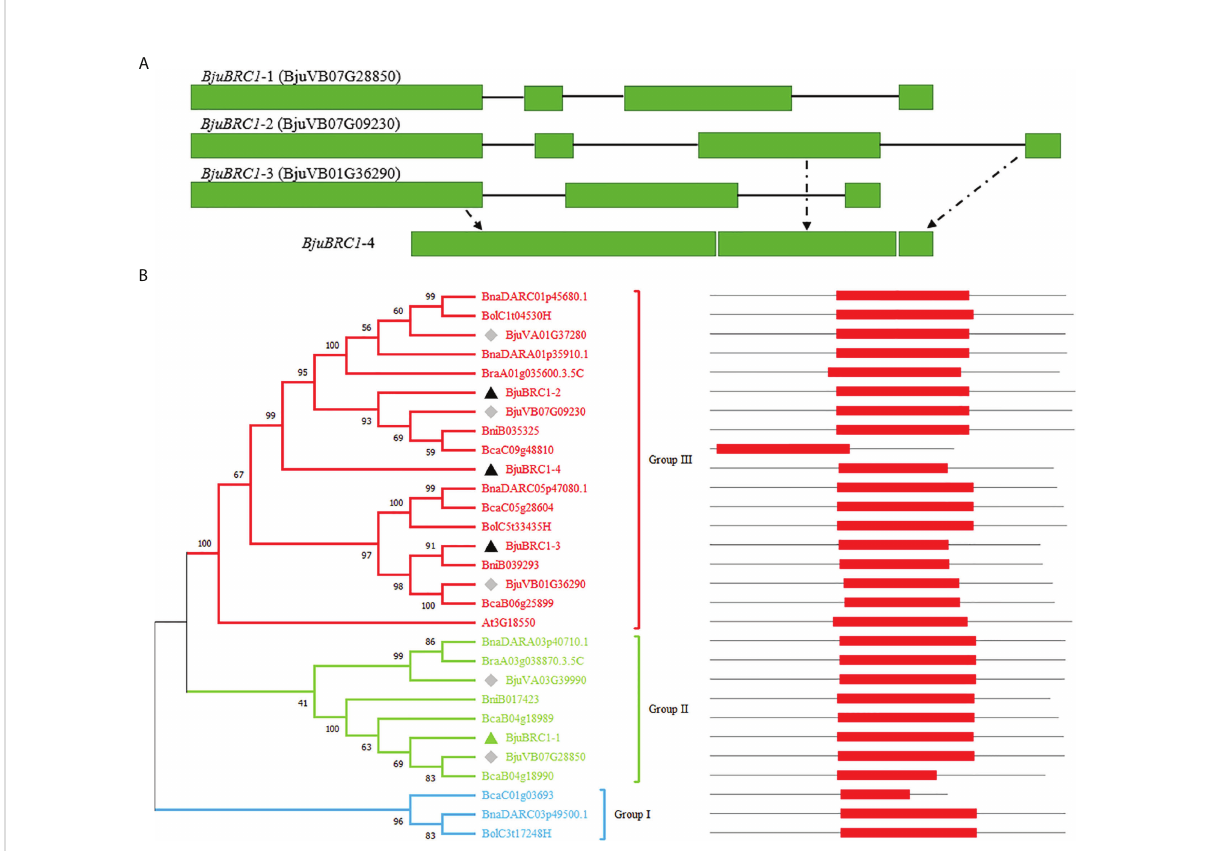
FIGURE 1 BjuBRC1 gene structure and phylogenetic tree. (A) BjuBRC1 gene structure. The green rectangle parts indicate exons; the black lines indicate introns. BjuBRC1 -4 has no accession number in the BRAD database, whose gene structure consists of parts of BjuBRC1 -2 and BjuBRC1 -3 (drawn by dotted lines). (B) Phylogenetic tree of BRC1 proteins from different plants in Brassicas ; the accession number of all genes are shown in the picture. BRC1 proteins are classed as three groups (red, green, and blue) according to their evolutionary relationship. Triangles indicate the genes cloned in this study, and the green triangle indicates representative genes chosen to be studied. The diamonds indicate homologous genes of BjuBRC1 in BRAD. The location of TCP domains (red rectangle) in AA sequences are shown on the